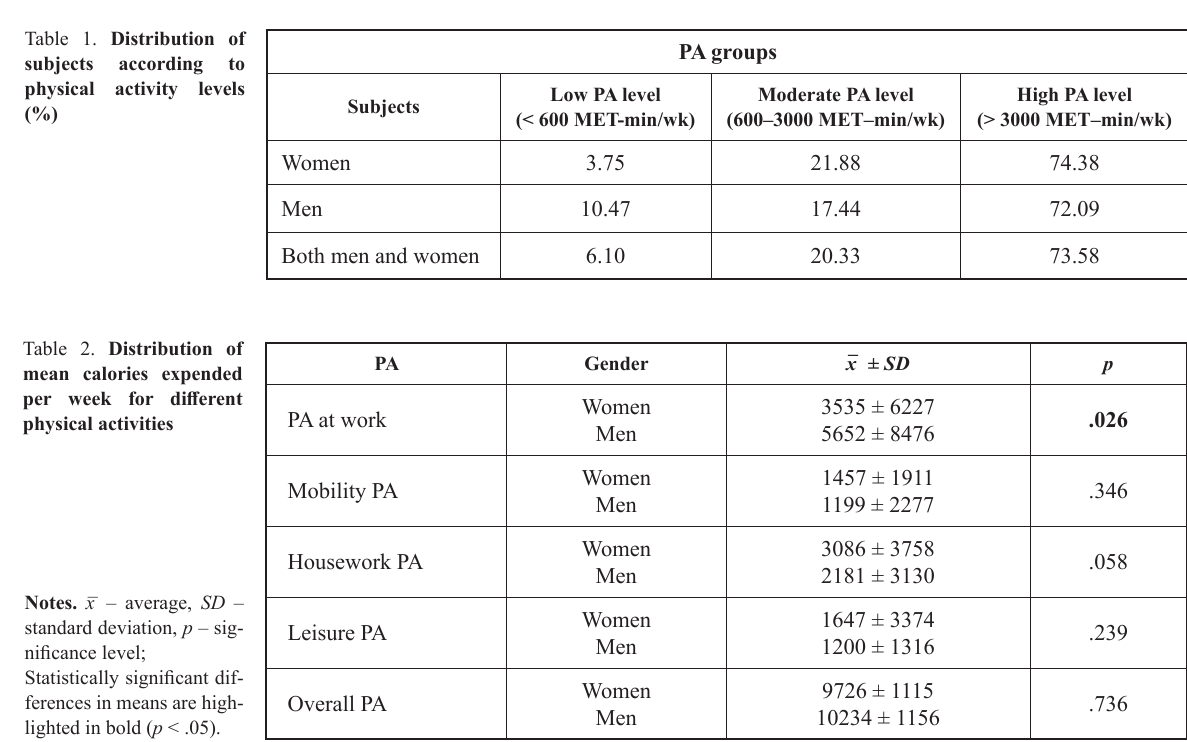
Table 1. Distribution of